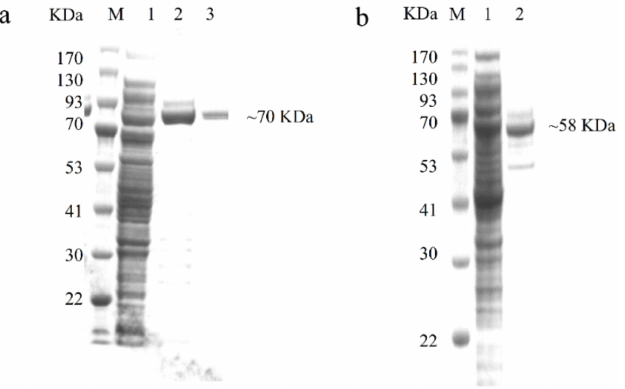
Figure 4. SDS-PAGE results of recombinant PhGDH1 and PhGDH2. ( a ): Expression analysis of recombinant PhGDH1, M: protein ladder, 1: Expression of PhGDH1 induced with 0.1 mM IPTG, 2–3: purified PhGDH1 fusion protein. ( b ): Expression analysis of recombinant PhGDH2, M: protein ladder, 1: Expression of PhGDH2 induced with 0.1 mM IPTG, 2: purified PhGDH2 fusion